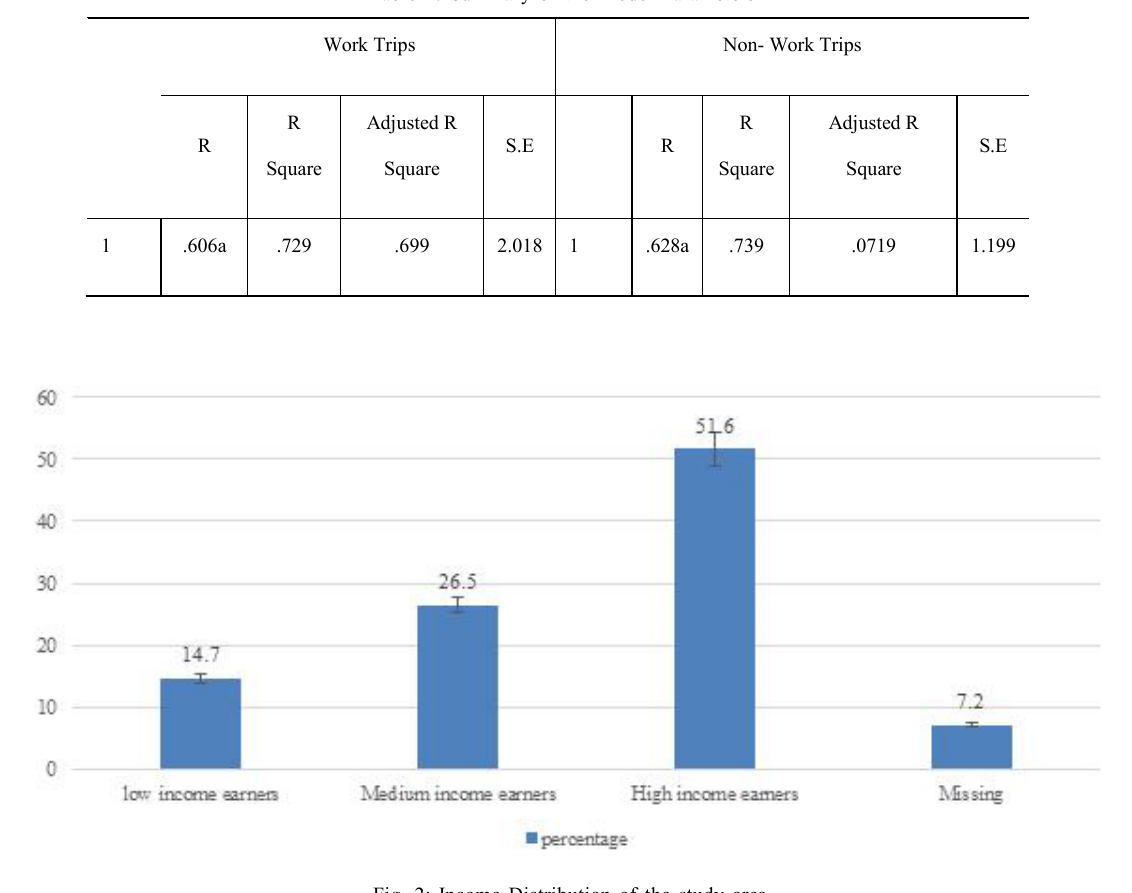
Fig. 2: Income Distribution of the study